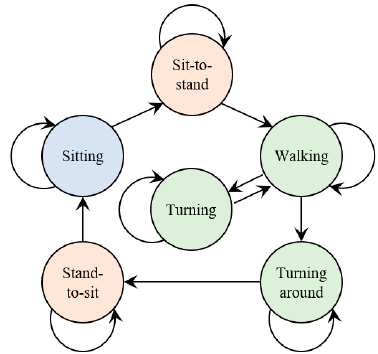
Figure 6. The knowledge-based postprocessing: ( a ) the fragmentation modification and ( b ) the motion inference.